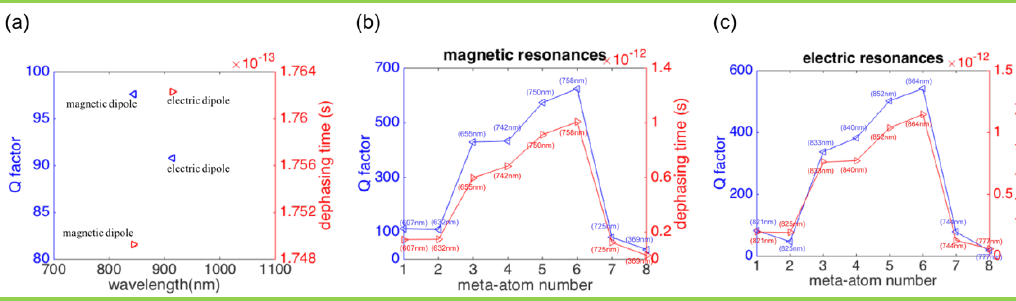
Figure A3. Q factors (blue marks) and dephasing times (red marks) of: ( a ) the electric dipole and magnetic dipole in Figure 1; ( b ) the magnetic resonances; and ( c ) electric resonances of the eight selected meta-atoms that are marked by stars in Figure 2.